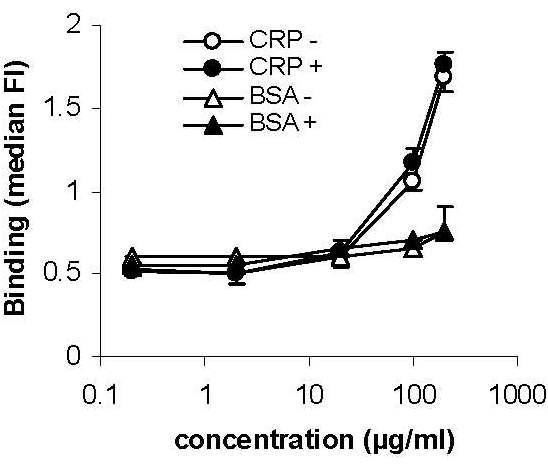
CRP does not bind to FcγRIIA. Jurkat cells transfected with empty vector (-; open symbols) or human FcγRIIA (+; closed symbols) were incubated with FITC-conjugated CRP (circles) or FITC-BSA control (triangles). There was no diffrence in binding between transfected and non-transfected cells.